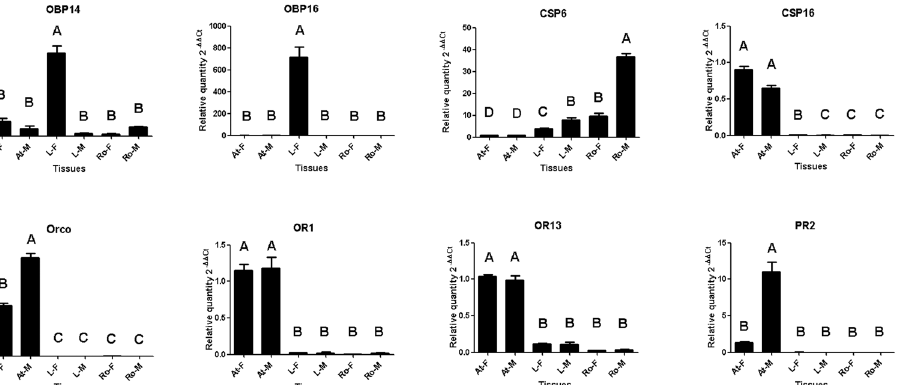
Fig 9. Expression levels of eight selected genes based on qPCR in different tissues. F: female; M: male; At: antennae; P: protarsus; Ro: reproductive organ. Different letters above bars indicate significant differences in expression levels between